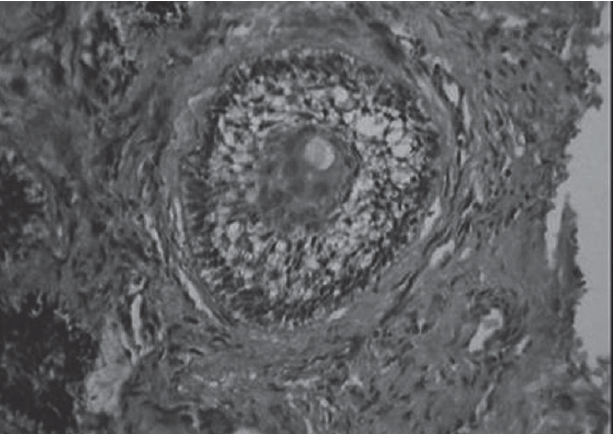
Fig. 9. Histological image showing dense collagen stroma with odontogenic epithelial cells arranged in the form of long, thin strands, giving an animal-like pattern configuration. The epithelial cells are hyperchromatic. These proliferations seem to be compressed by dense stroma.